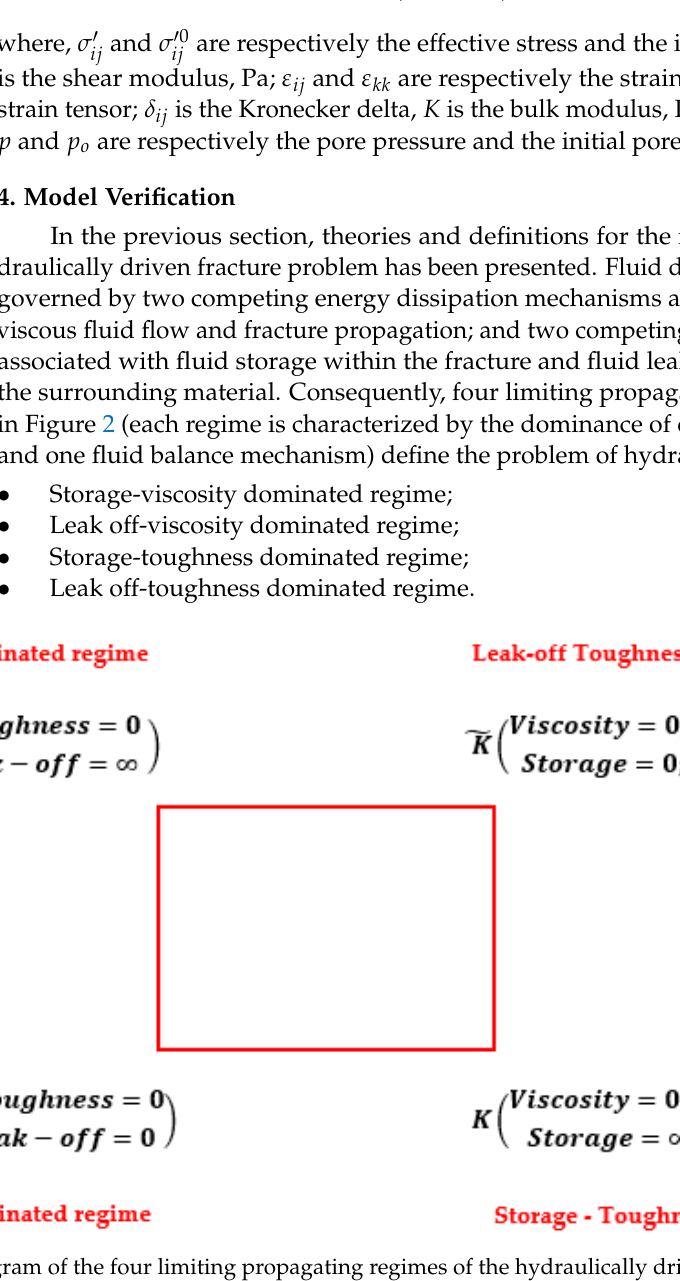
Figure 2. Parametric diagram of the four limiting propagating regimes of the hydraulically driven fracture problem [22].